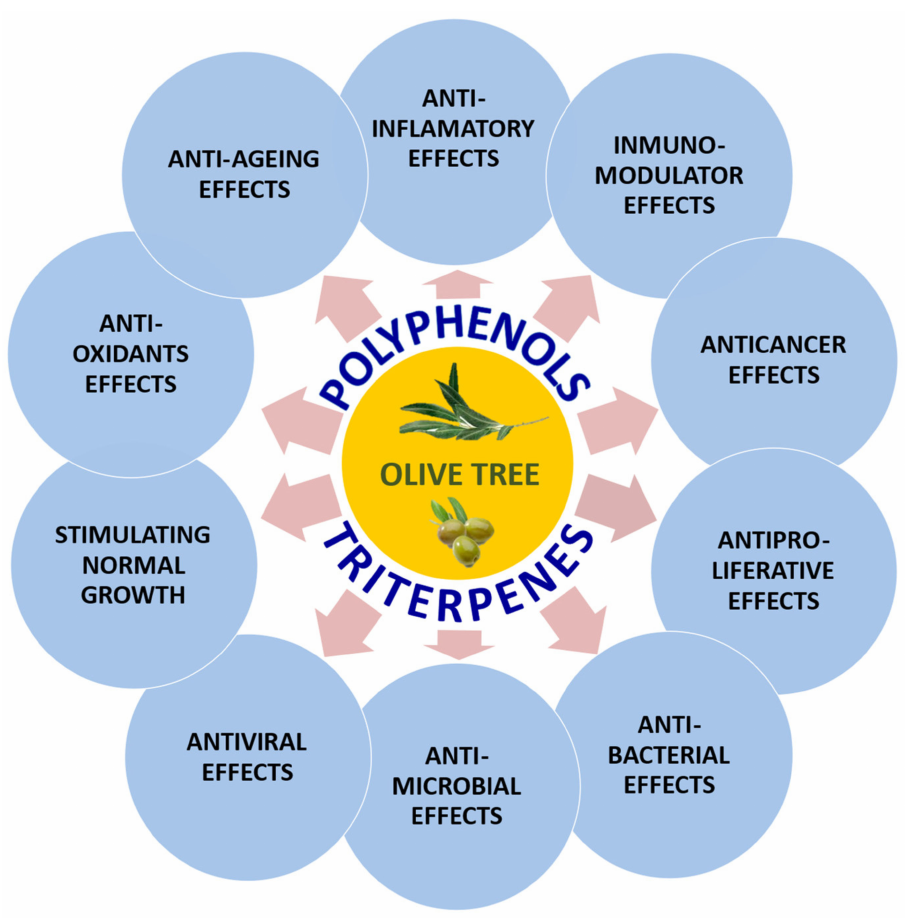
Figure 1. Main bioactivities of polyphenolic and triterpenoid compounds present in olive fruit and leaves related to the prevention and cure of different